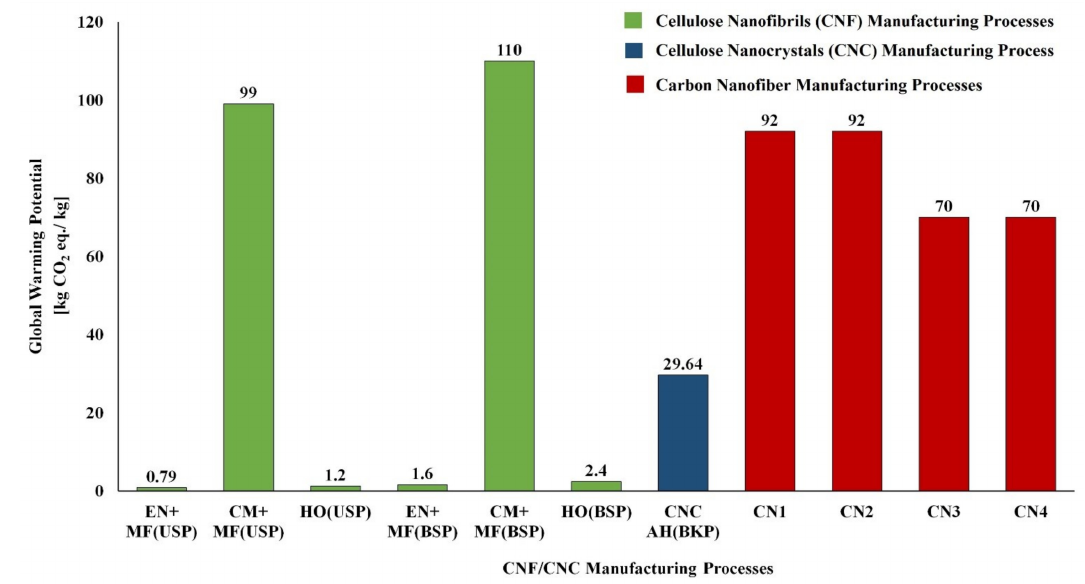
Figure 8. Comparison of GWP of different CNF and CNC manufacturing processes with car- bon nanofiber manufacturing processes Note: AH—Acid hydrolysis, BKP-Bleached kraft pulp, BSP-Bleached sulfate pulp, CM—Carboxymethylation pretreatment, CN1—Carbon nanofiber from methane feedstock, CN2—Carbon nanofiber from methane feedstock with an H 2 carrier gas, CN3— Carbon nanofiber from ethylene feedstock with an H 2 carrier gas, CN4—Carbon nanofiber from benzene feedstock, CNC—Cellulose nanocrystals, EN—Enzymatic pretreatment, HO—High pressure homogenizer, MF—Microfluidizer, USP—Unbleached sulfate